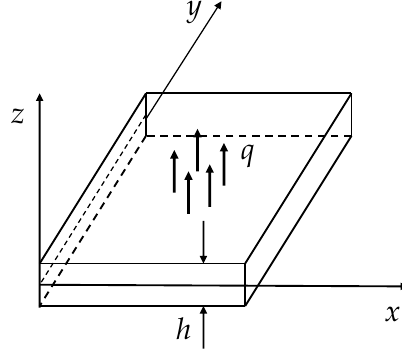
Figure 1. A thin rectangular plate showing transverse loading and dimensions.